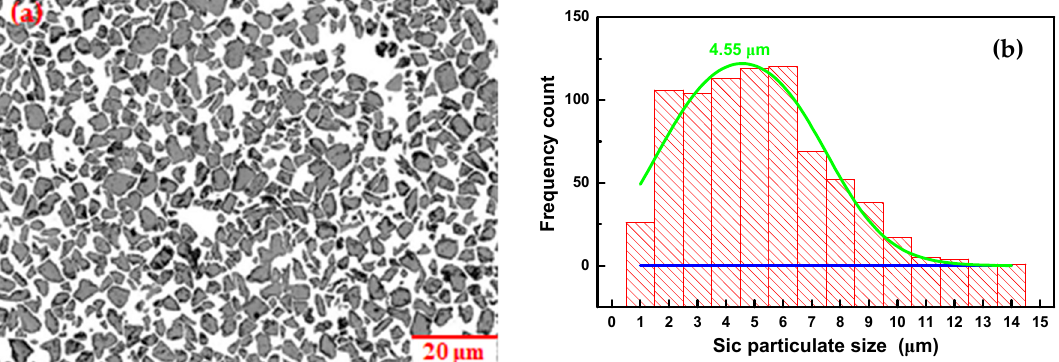
Figure 7. ( a ) Microstructure and ( b ) SiC particulate size distribution of Al6063/SiC p /65p composites.